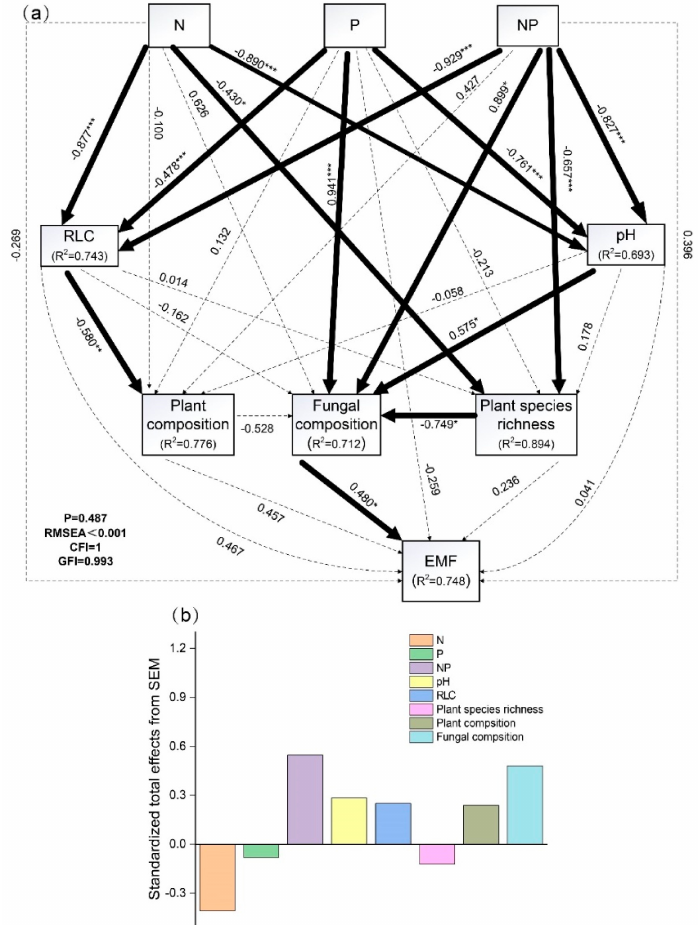
Figure 6. Structural equation model (SEM) of the effect of nitrogen and phosphorus addition on ecosystem multifunctionality, including ( a ) structural equation model; ( b ) standardized total effects from SEM. The solid line represents the path with significant influence (*, **, and *** indicated p < 0.05, p < 0.01, and p < 0.001, respectively), the dotted line represents the path with no significant influence, the number on the solid and dotted line represents the standardized path coefficient, and the R 2 value represents the proportion of variation explained by causal relationships with other variables. Abbreviations: Control, the control without any nutrient addition; N, N-alone addition; P, P-alone addition; NP, N and P together addition; pH, soil acidity and alkalinity; RLC, relative light conditions; EMF, ecosystem multifunctionality; P, probability level; RMSEA, root mean square error of approximation; CFI, Comparative fit index; GFI, goodness-of-fit